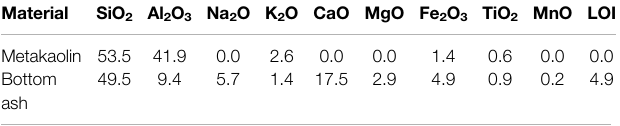
TABLE 1 | Composition of the raw materials